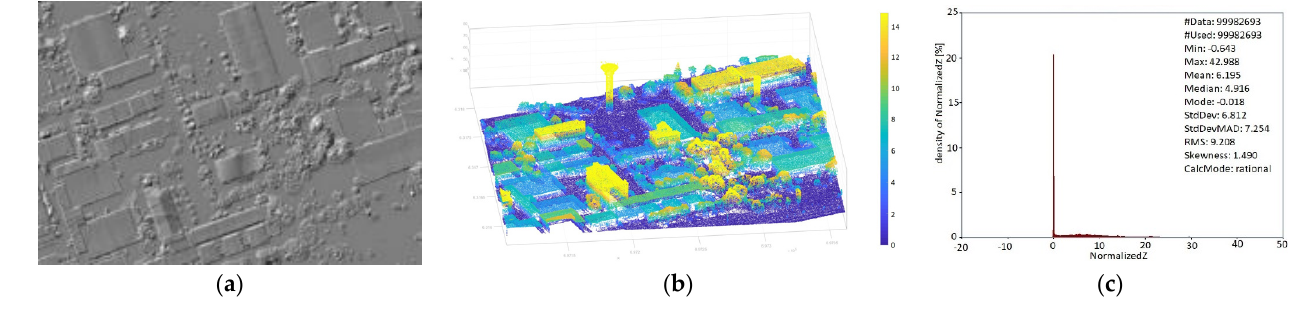
Figure 11. ( a ) Shaded nDSM in raster format ‐ a detail, ( b ) the point cloud containing the heights above the earth surface created based on nDSM raster, ( c ) the histogram of the off ‐ ground points heights.